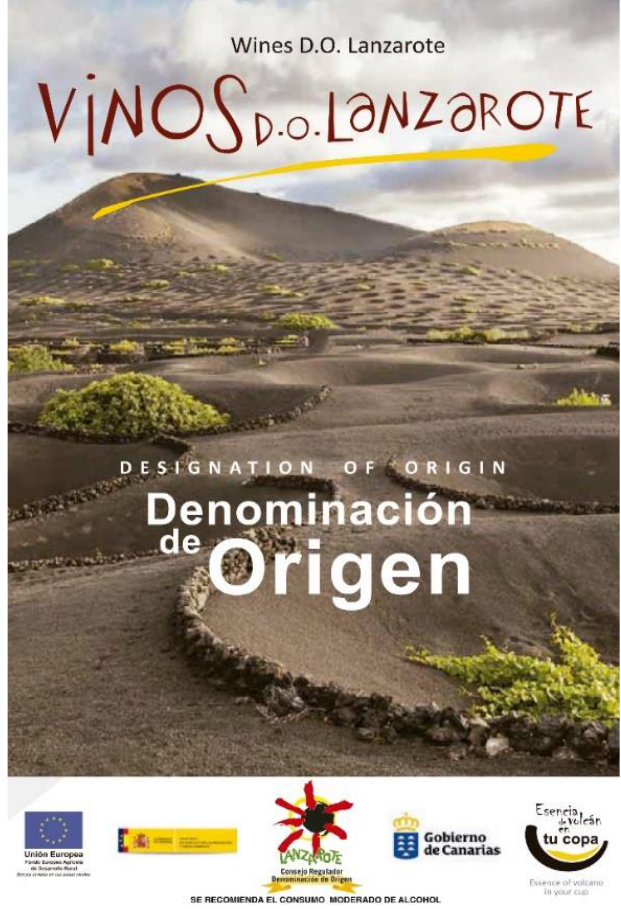
Figure 3. Scenarios of heroic viticulture in the Lanzarote AO, (Islas Canaria: España). Source: Regulatory Council of the Appellation of Origin, Lanzarote [34].